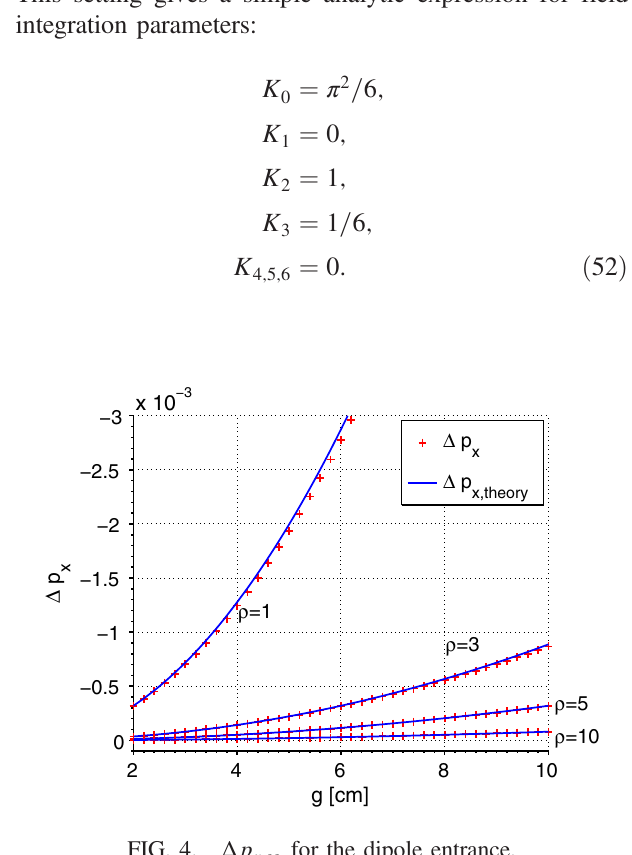
FIG. 4. Δ p for the dipole x; co